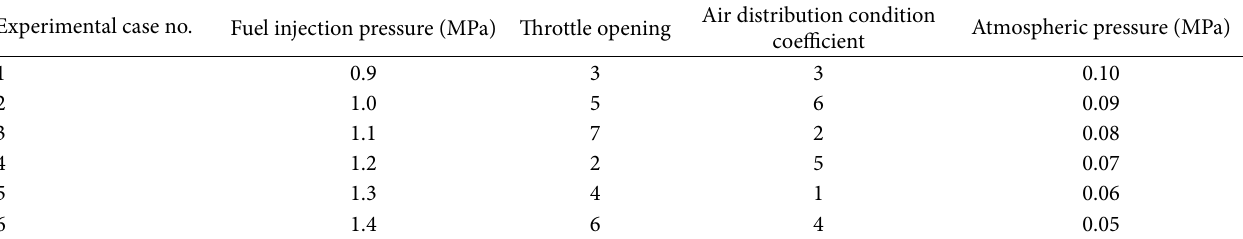
Table 1: Plan of the uniform experiment.